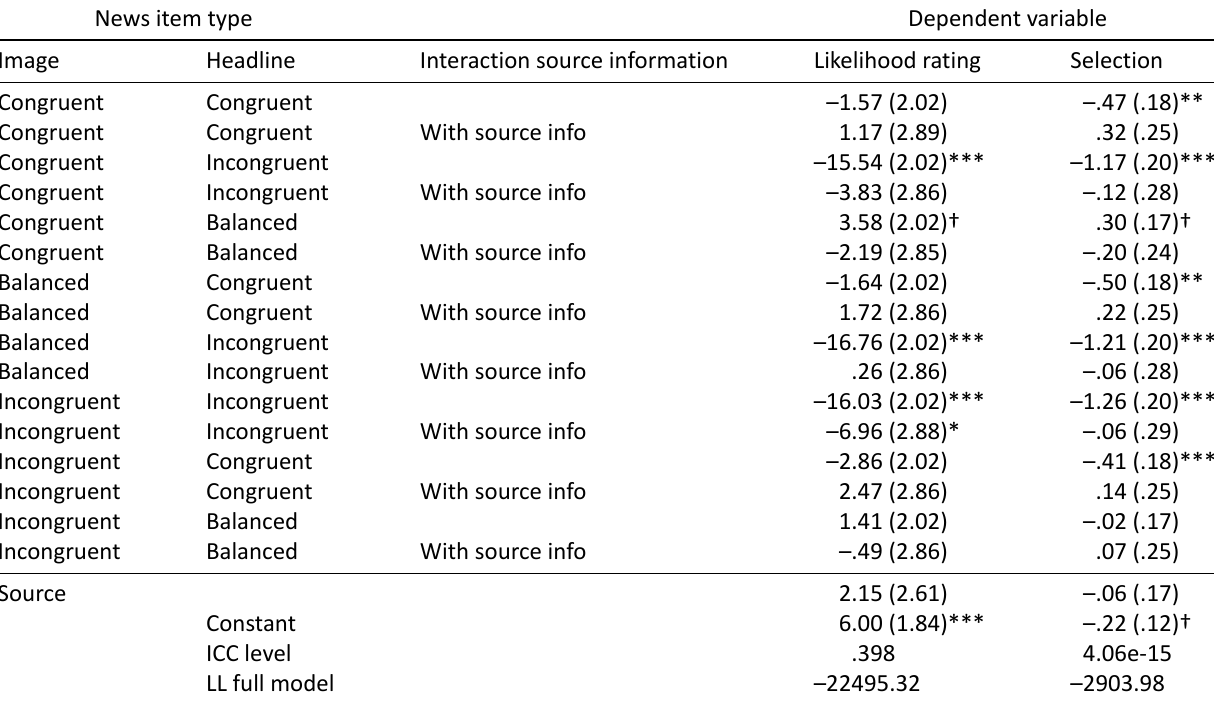
Table B4. Gun ownership context, multilevel models explaining peoples’ likelihood of viewing and selection of a news item, interacted with source